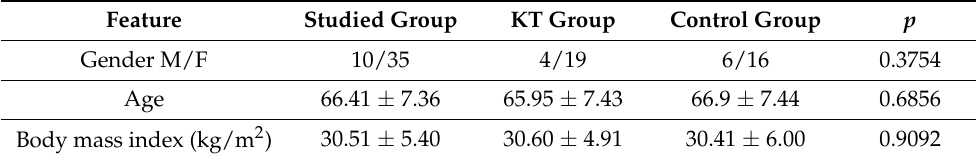
Table 1. Demographic and clinical features of the studied